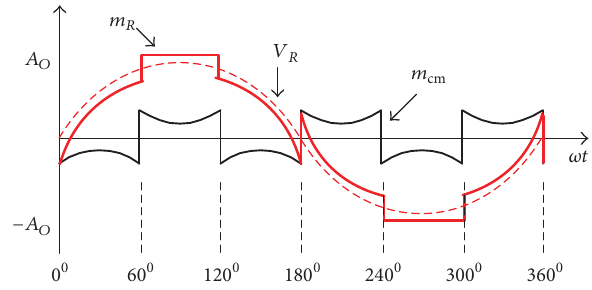
Figure 5: 60 ∘ bus-clamping modulating signal.